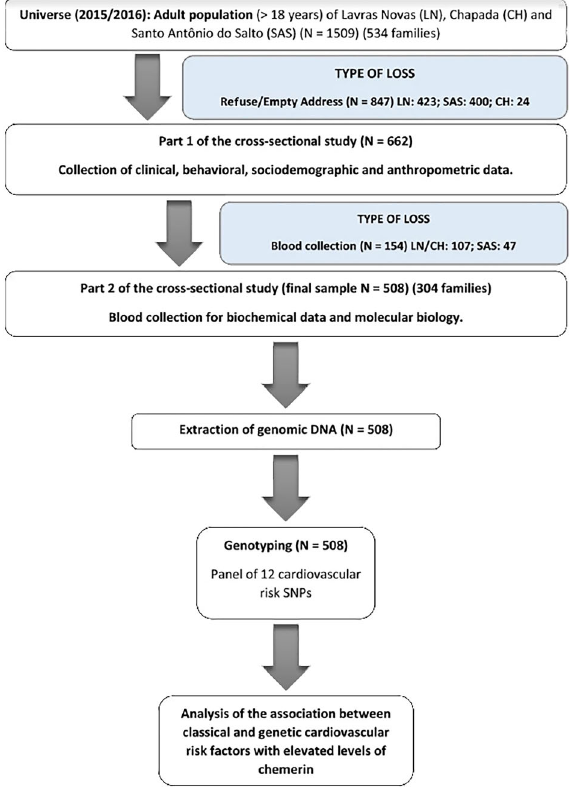
Figure 1. Sampling process and analysis stages of the present study. SNP: single nucleotide